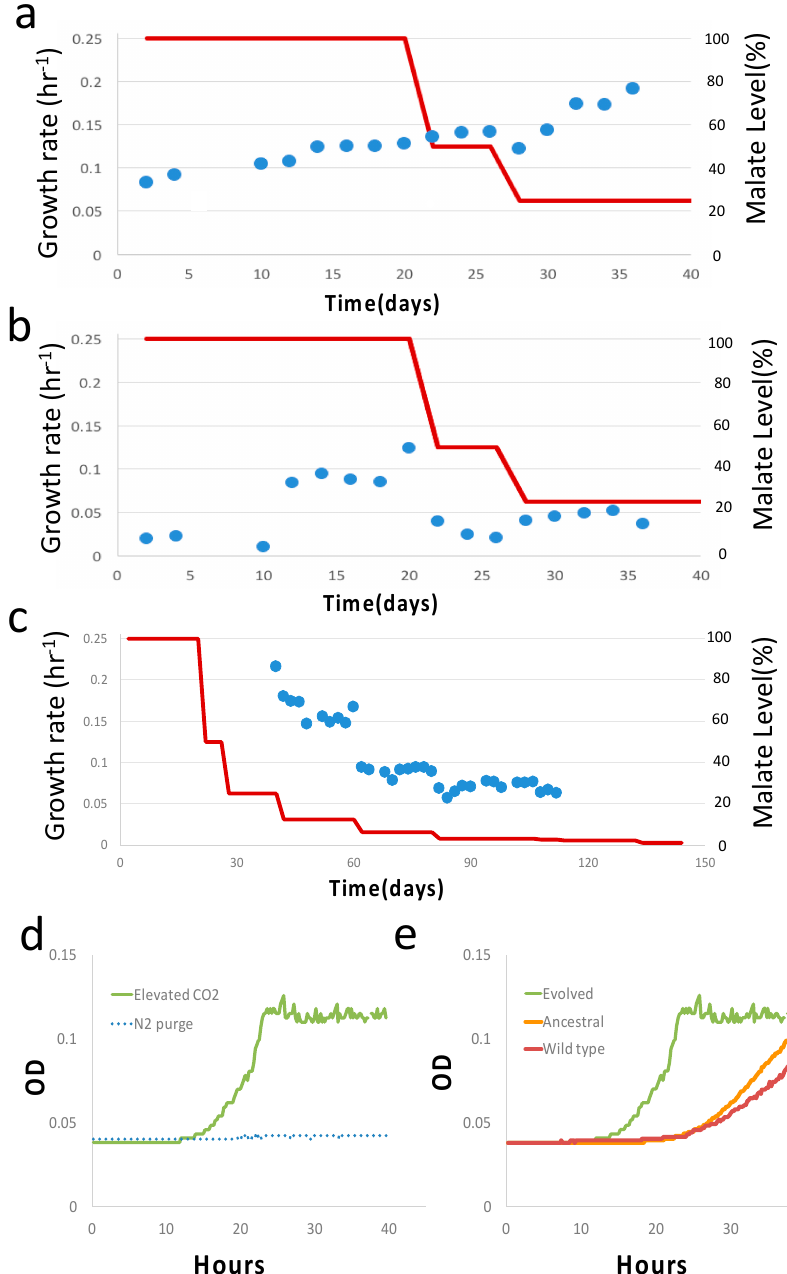
Figure 3. Results of the second stage of evolution with malate. ( a ) Primary growth rate of diauxic growth during the second stage of evolution with malate level (red line). ( b ) Secondary growth rate (blue dots) of diauxic growth during the second stage of evolution with malate level (red line). ( c ) Growth rate of single phase of growth from 40th day onward. Data are omitted from 112th day onward due to lack of resolution for growth rate calculation. ( d ) Growth curve of the evolved clone at the end of evolution (144th day) at elevated CO 2 level (pCO 2 = 0.2 atm) and no CO 2 (N 2 purge) at 25% malate concentration with H 2 supply. ( e ) Growth curve of the evolved clone, ancestral strain, and control wild-type sample (BW25113 strain) at elevated CO 2 level (pCO 2 = 0.2 atm) and at 25% malate concentration. In all figures, 100% malate concentration corresponds to 4.9 g/L. At the end of long-term (~184 days in total) two-stage (40 days in serine and 144 days in malate) evolution, frozen samples were thawed and checked. We checked the evolved